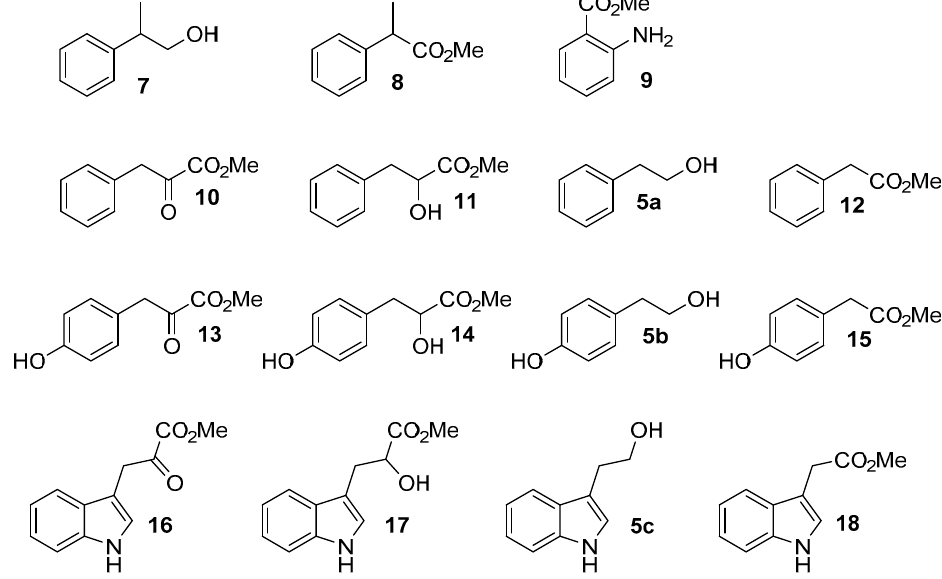
Figure 2. Reference standards used for GC-MS analysis of the biotransformation experiments.